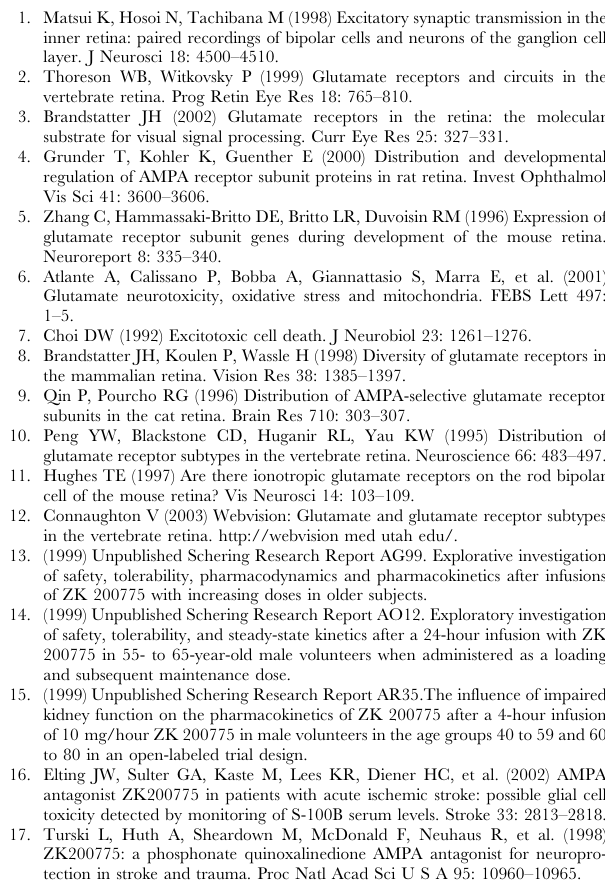
Table S2 Eye position. Data for both eyes for each group before infusion and 4 and 22 hours after infusion of ZK 200775. No significant changes occurred.